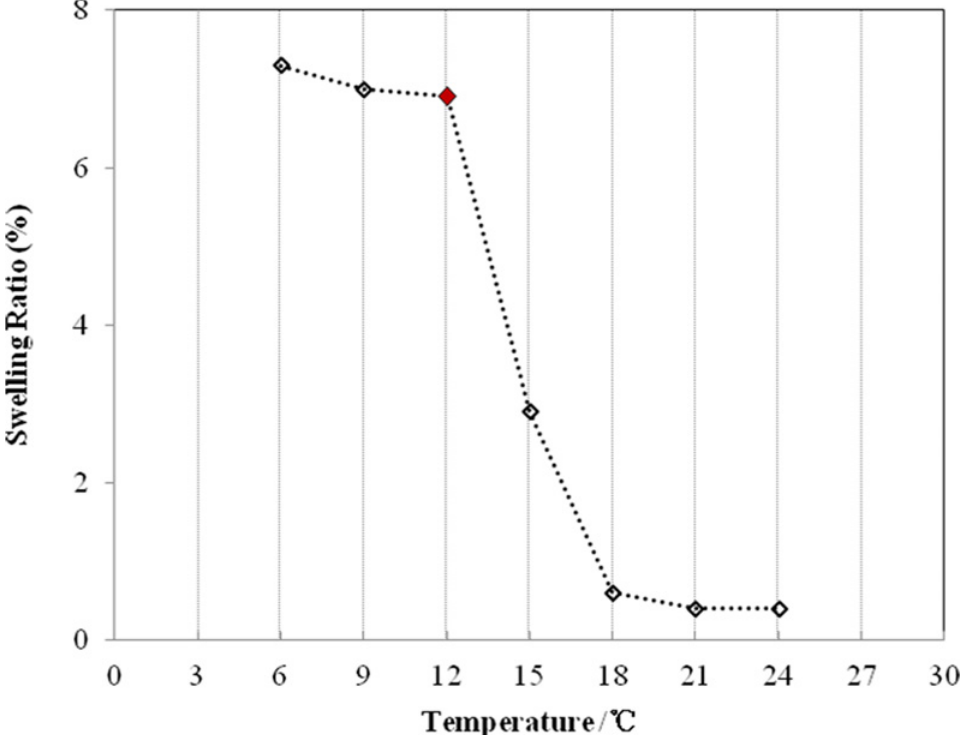
Fig 2. The lower critical solution temperature (LCST) profile of P(NIPAm- co -BMA) hydrogel. P(NIPAm- co -BMA) is poly (N-isopropyl acrylamide- co - butylmethacrylate). The LCST was determined from the sharp change point (indicated by red diamond) in the curve of the swelling ratio vs.